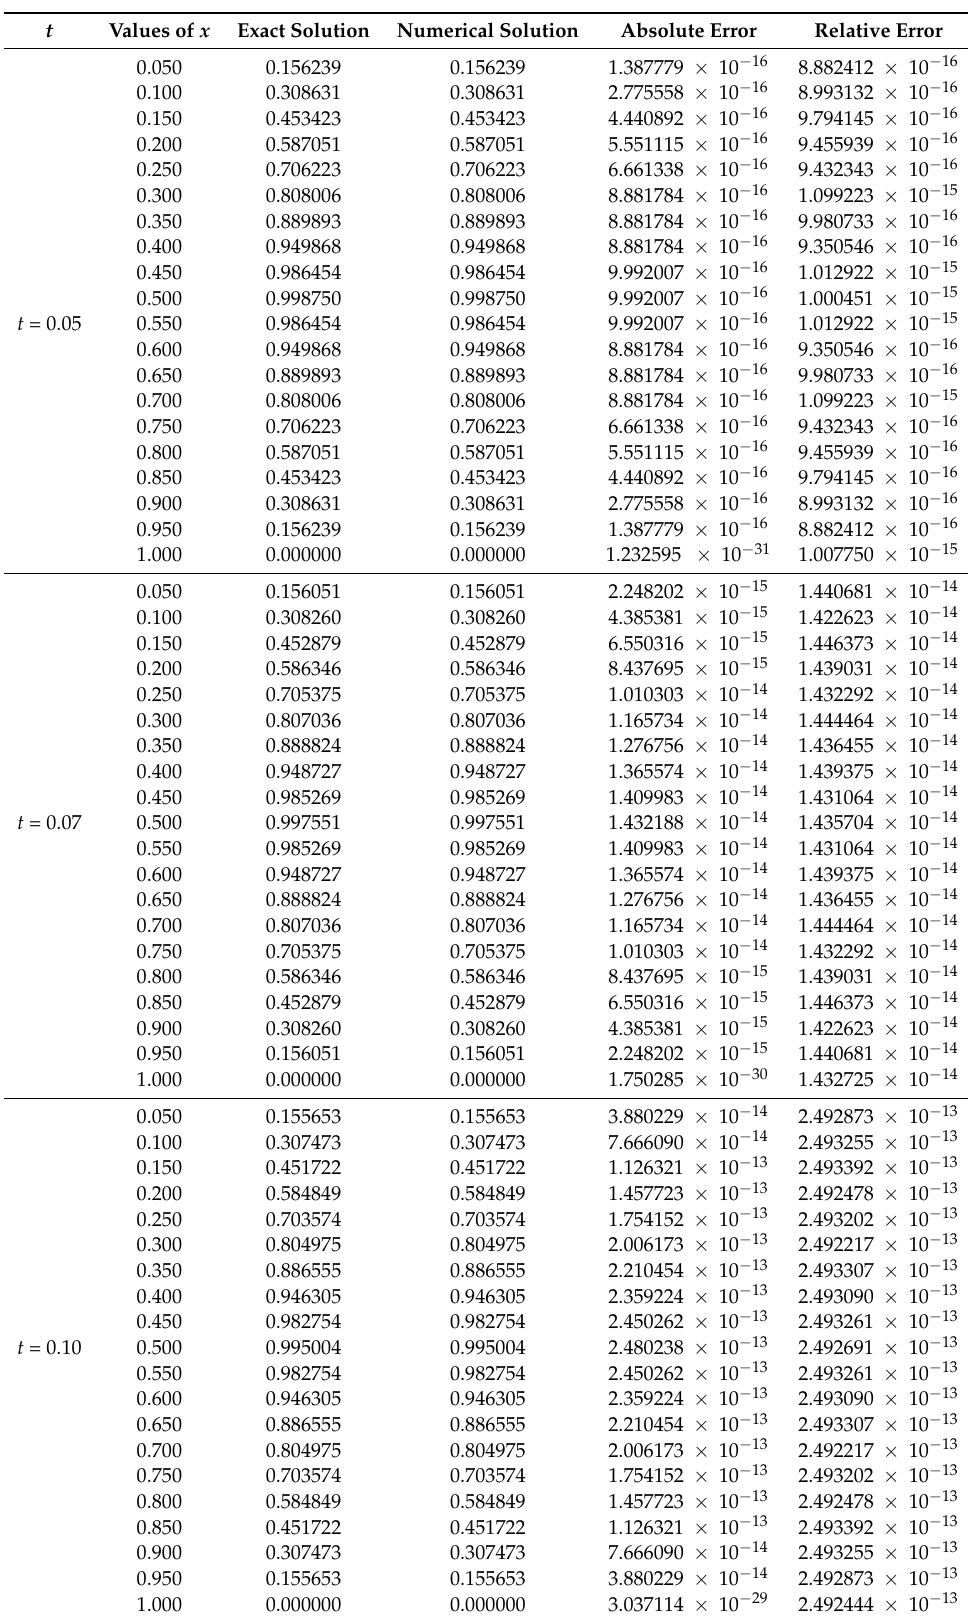
Table 5. Absolute and relative errors at some values of x obtained at times 0.05, 0.07, 0.10 using 7-terms of RDTM (for numerical experiment